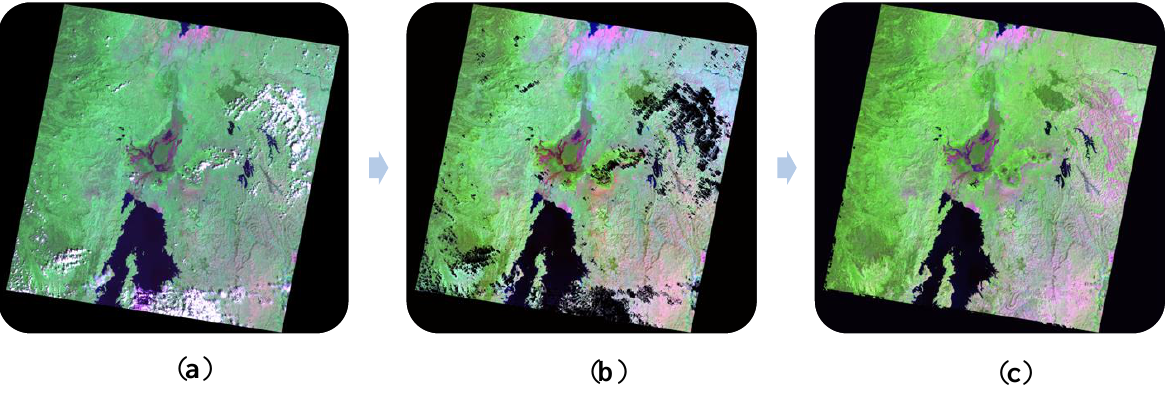
Figure 5. Results of Landsat (RGB = TM bands 7,4,2) time composite formation for the north region (Path/Row 173/61) of the study area. ( a ) Primary Landsat image collected 11 December 2001; ( b ) after cloud and shadow removal; and ( c ) Landsat time composite